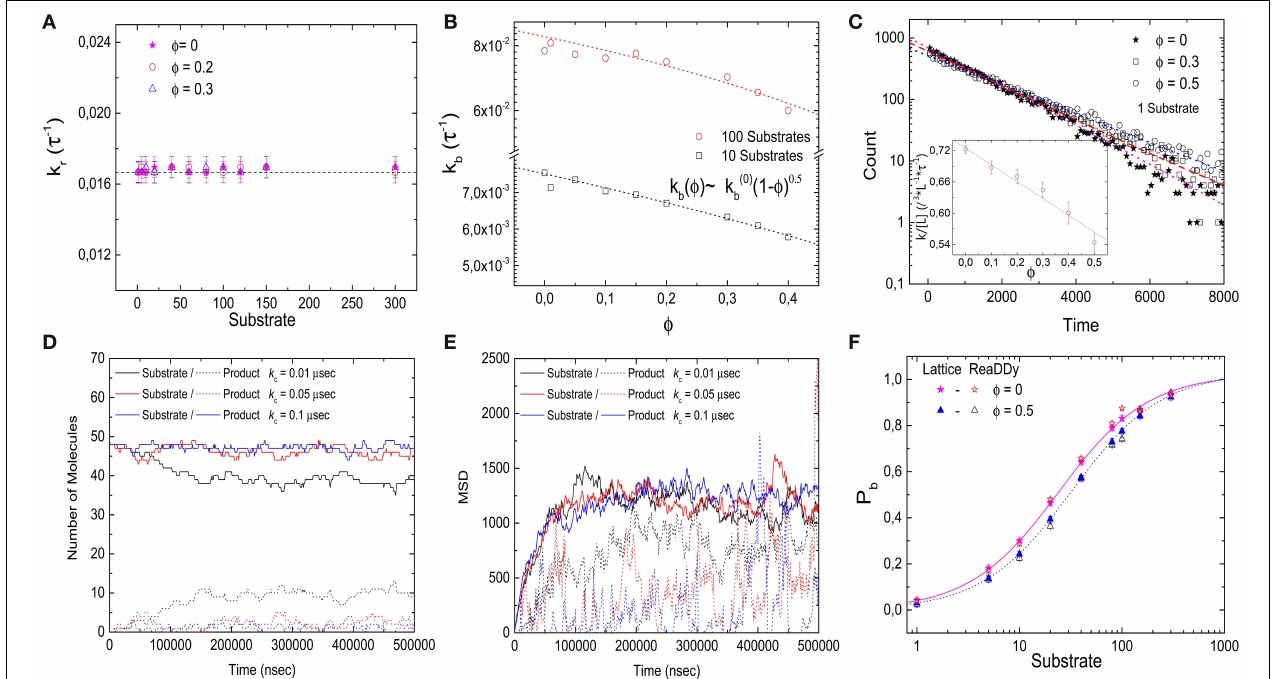
ReaDDy. Number of particles (D) and mean square displacement (E) FIGURE 6 | Kinetics of the diffusion-limited reaction. (A) Reaction from the target as functions of time for different charging rates. The rate k r as a function of the number of substrate molecules for solid lines represent the substrate particles (ligands) that can bind and different levels of volume occupation φ . k r stays constant and has a react, the dashed lines represent the product that needs to be value of k r 1 / 60 τ − 1 for all substrate numbers and levels of φ . (B) = recharged with rate k c before it can bind again. (F) Comparison of Binding rate k b decays as φ increases. The simulation data is fitted the binding probability P b as a function of the number of ligands at with Equation (8), resulting in κ 0 . 5 (lines). (C) Binding time ≃ different crowding levels for ReaDDy simulations and the lattice model histograms fitted with a single-exponential. (Inset) The characteristic (data from Figure 5A ). Simulation parameters time increases as the levels of volume occupation increase. (D,E) Trajectories of the implementation of the diffusion-limited reaction with